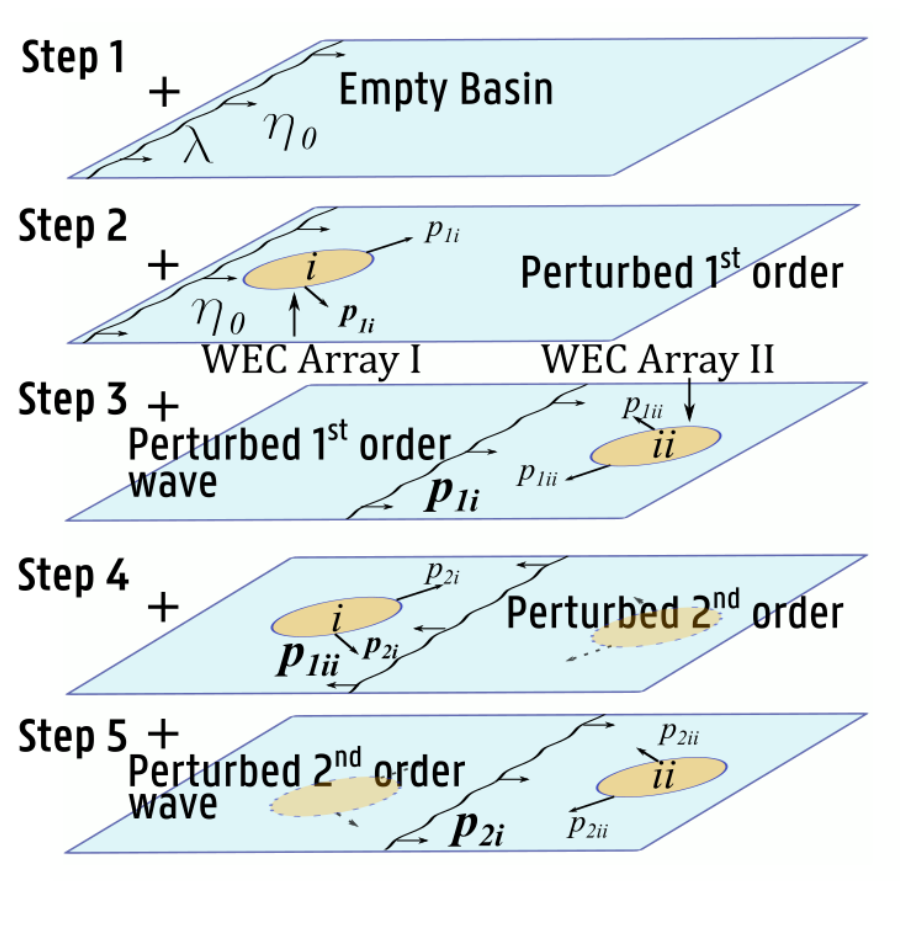
Figure 9. Iterative procedure for determining the perturbed wave field for a regular wave input. Incident wave λ is coming from the left